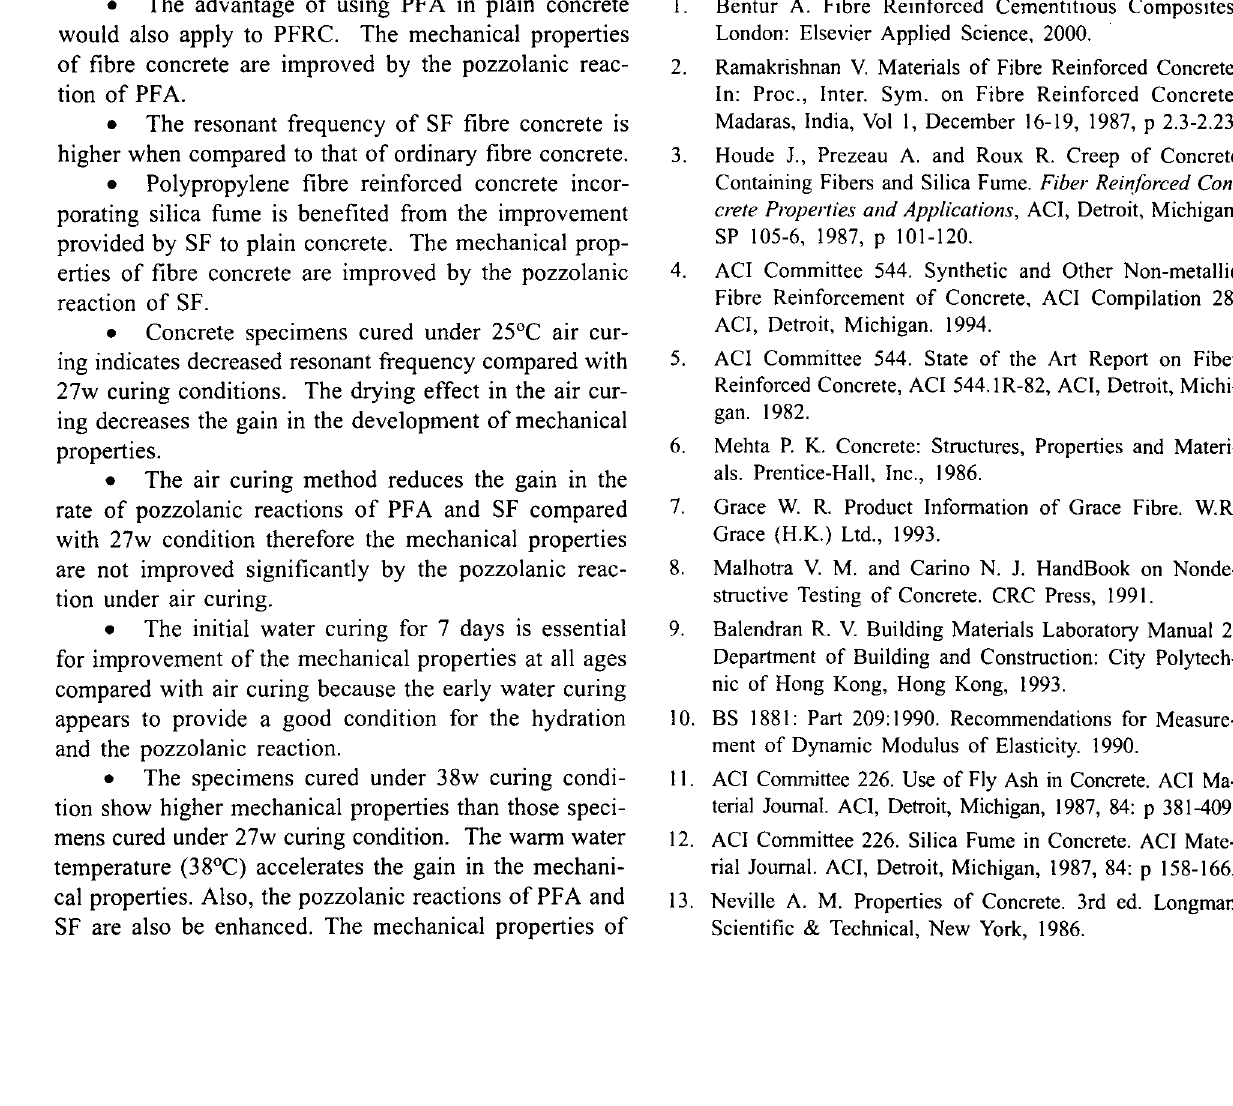
fibre concrete with pozzolans improve under 38w condi tion compared with 27w